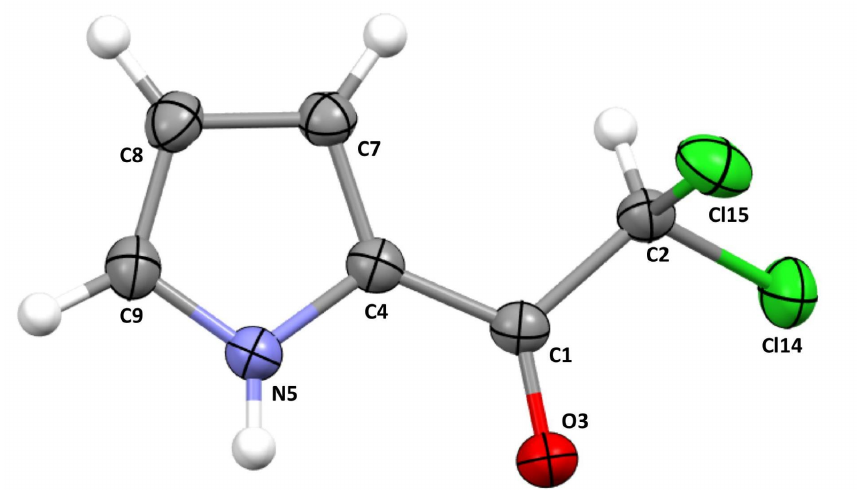
Figure 1. Crystallographic structure of 2,2-dichloro-1-(1H-pyrrol-2-yl)ethan-1-one (CCDC refcode: 2120678). Atomic displacement ellipsoids are drawn with a 50% probability level. The labels of individual atoms used in the article are also